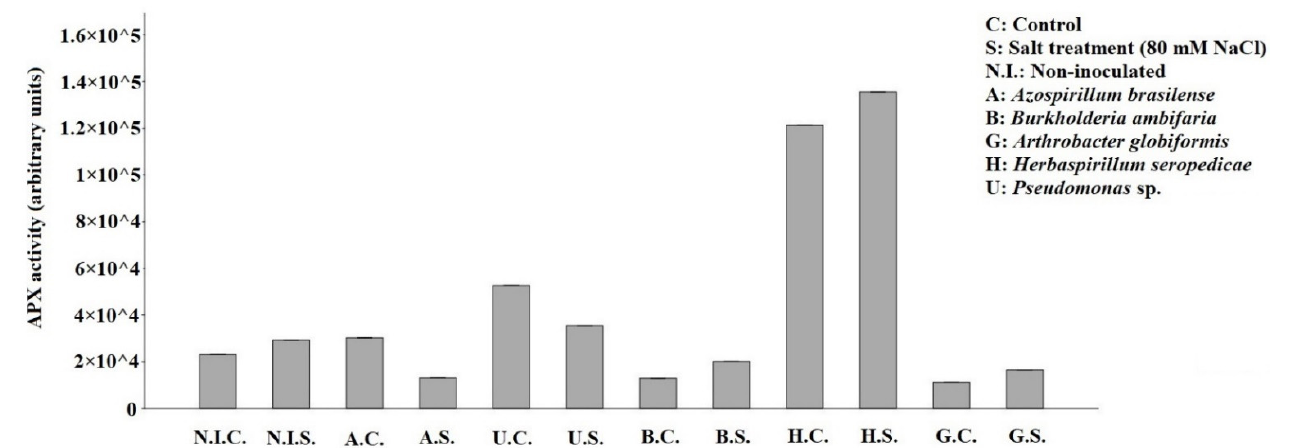
Figure 5. APX activity of B. napus grown in non-saline (C) and in saline soils (S). Table 2. Proline and phenolic compounds of B. napus cv. SY Saveo grown for 30 days on non-saline soil (C) or saline soil (S). Plants were inoculated with plant growth-promoting bacteria (A = A brasilense , B = B ambifaria , G = A globiformis , H = H seropedicae , U = Pseudomonas sp. UW4) or not (N.I. = non-inoculated). Different letter means significant difference within the same bacterial treatment. Significant differences between inoculated or not inoculated plants grown at the same soil conditions are marked as * ( p < 0.05), *** ( p < 0.001) ( n = 9). Proline (nmoles/mg f.w.)